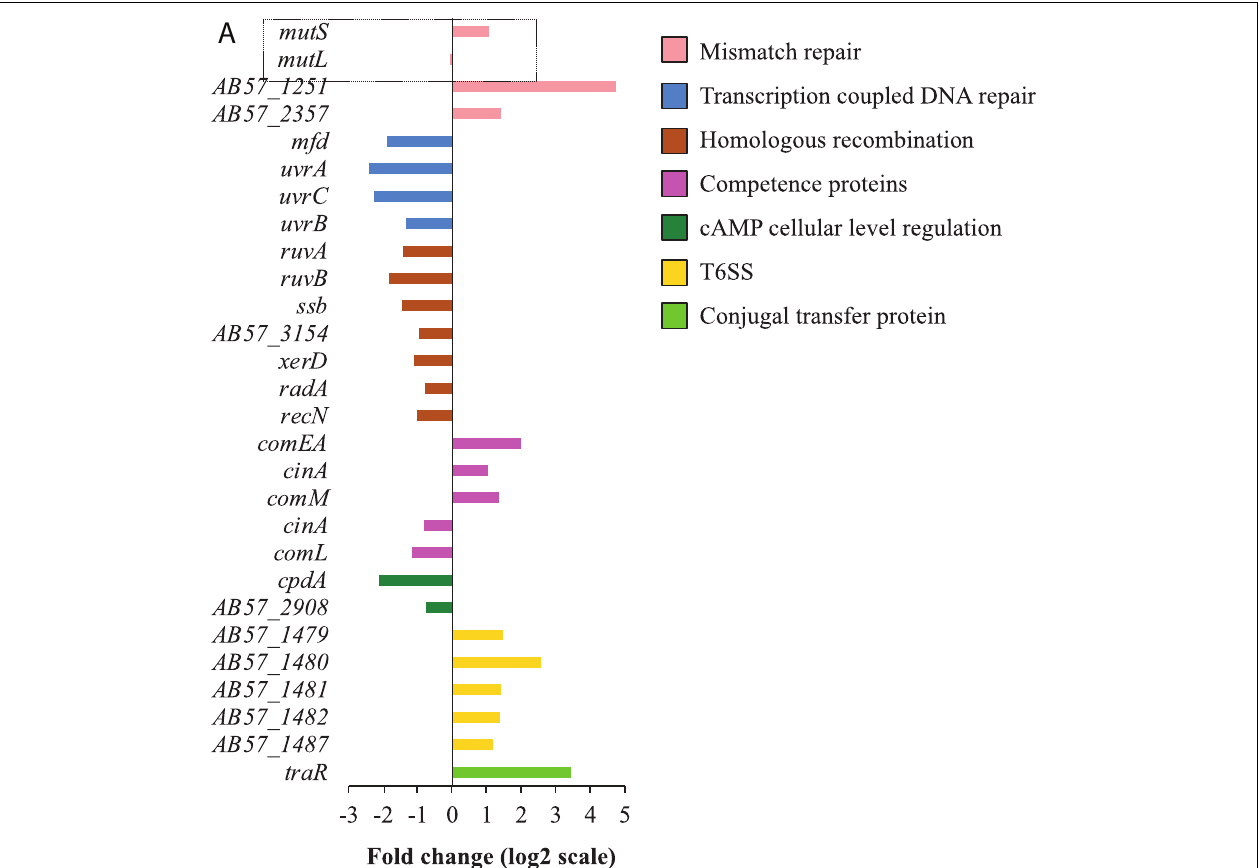
FIGURE 3 | Tigecycline affects transcription of genes involved in DNA repair and HGT. (A) For each functional group, only differentially transcribed genes with absolute fold changes > 1 (log 2 scale) and padj < 0.01 are shown. The bar charts are grouped by colors according to the biological functions of the genes assigned, with the color scheme on the right. Full information on gene function annotations is given in Supplementary Data .